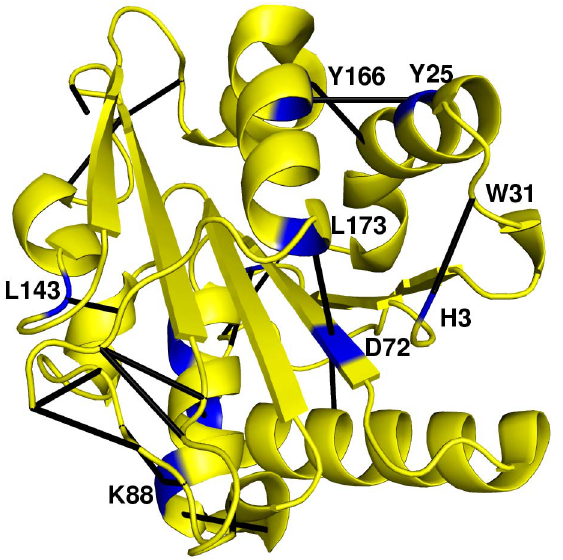
Figure 8. Ten residues showing highest increase in BC along with the contacts made mapped on the WT structure. Residues are shown in Blue and the Black lines represent the new contacts made in the 6B mutant as compared to WT PCN.